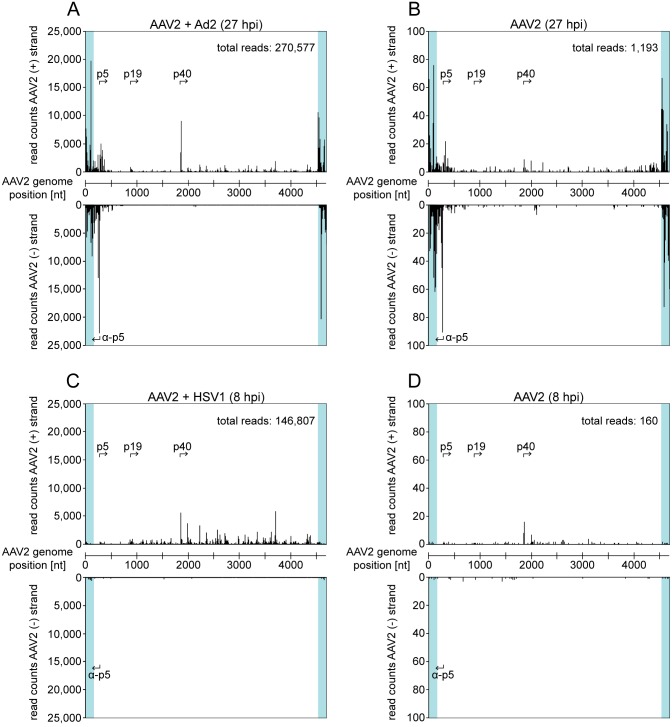
Small RNA-Seq: Read mapping of small AAV2-specific RNAs to either strand of the genome.(A) Mapping of AAV2-specific reads identified by the small RNA-Seq analysis in AAV2/Ad2 co-infected HeLa cells 27 hours p.i. (hpi). The AAV2 genome scale is displayed in the center. Reads mapped to the AAV2 (+) strand are displayed above and those mapped to the AAV2 (-) strand below the genome, read counts are shown in intervals of 10 nucleotides. The ITR regions are highlighted in turquoise. The positions of the known AAV promoters on either strand are indicated by arrows. The total read count is indicated. Note the ambiguous assignment of reads mapping to the ITRs. (B) Mapping of small AAV2-specific reads in AAV2 infected HeLa cells 27 hpi, displayed as in (A). (C) Mapping of small AAV2-specific reads in AAV2/HSV1 co-infected HeLa cells 8 hpi, displayed as in (A). (D) Mapping of small AAV2-specific reads in AAV2 infected HeLa cells 8 hpi, displayed as in (A). Note the different scales of read counts in (A to B) and (C to D).